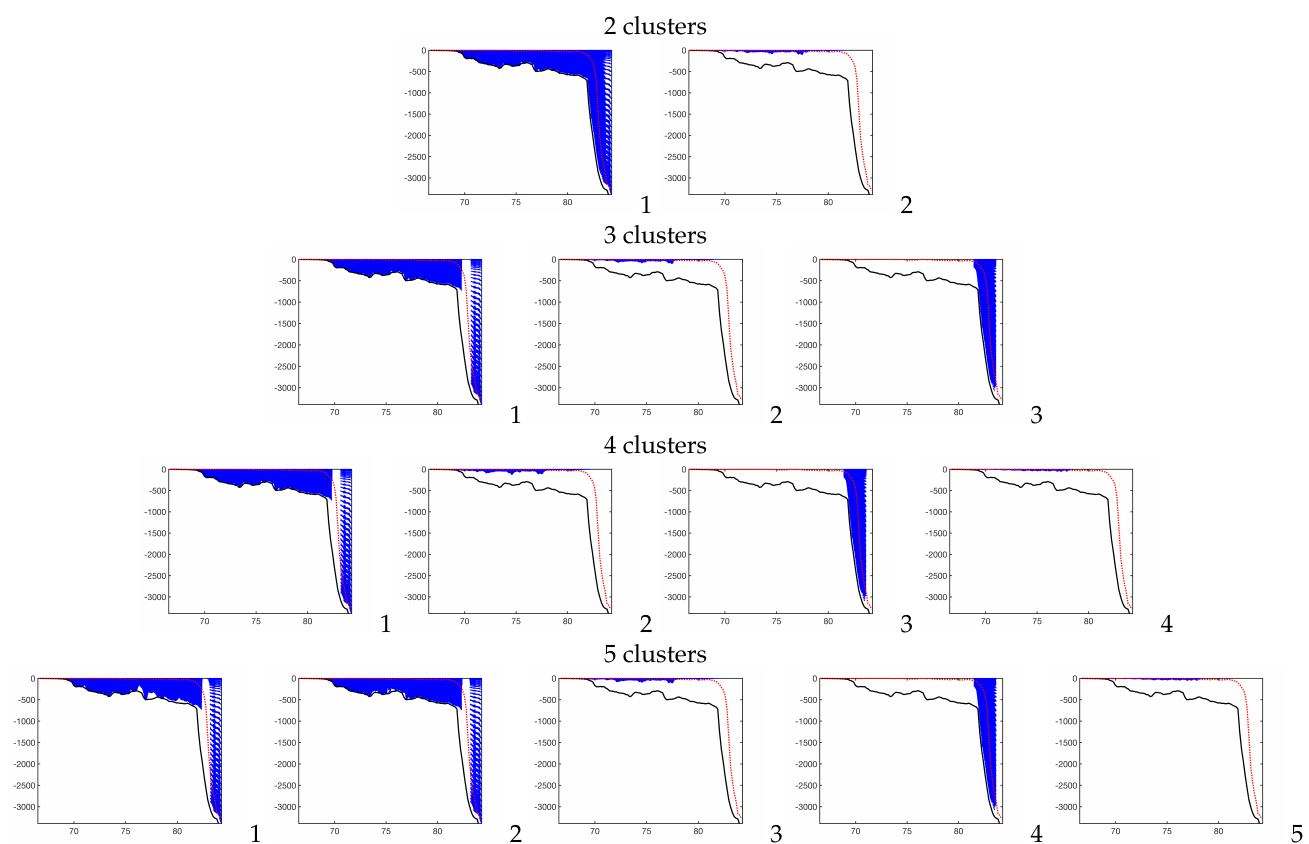
Figure 3. Localization of clusters in depth (vertical axis) depending on latitude (horizontal axis) when the sample is divided into 2, 3, 4, and 5 clusters: the labels are similar to Figure 2, the solid black line shows the maximum depth for different latitudes of the Kara Sea, the dotted red line shows the minimum depth. The position of each element on this section is marked with blue dot, thus the white area represents localities where there are no cluster